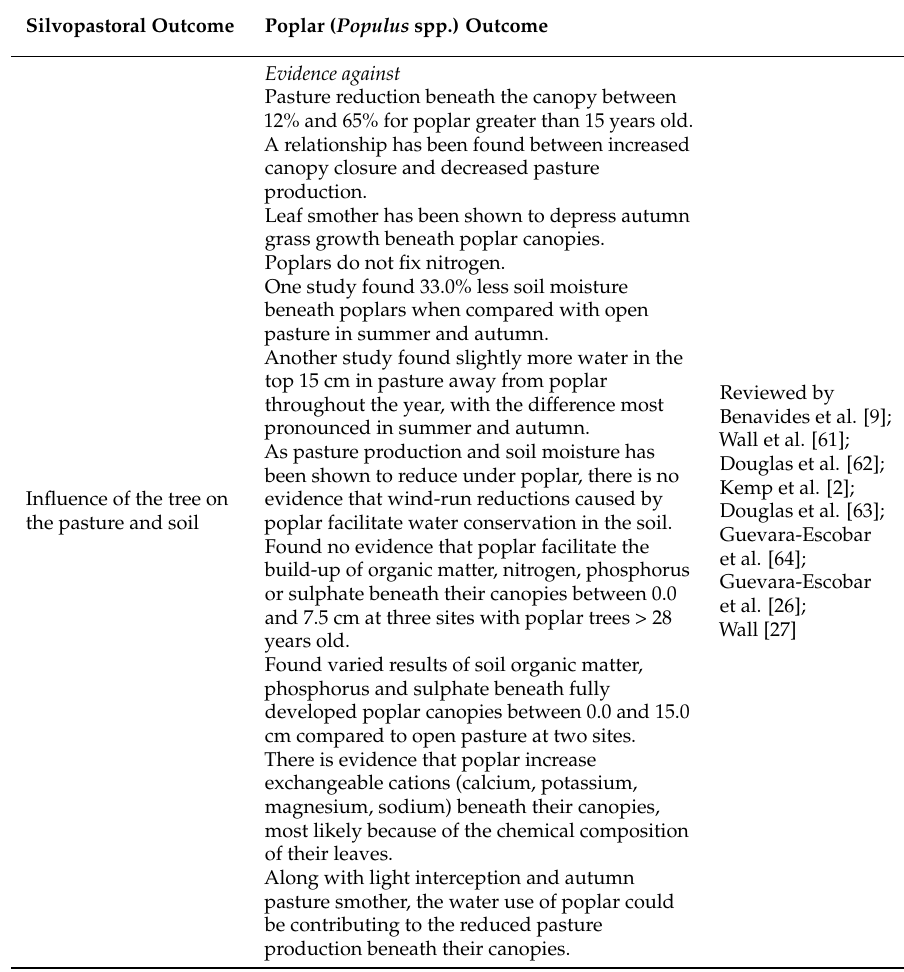
Table 3. Silvopastoral outcomes for poplar ( Populus spp.) and k¯anuka ( Kunzea spp.) in a New Zealand hill country silvopastoral system. Tree outcomes have been adapted from Wood